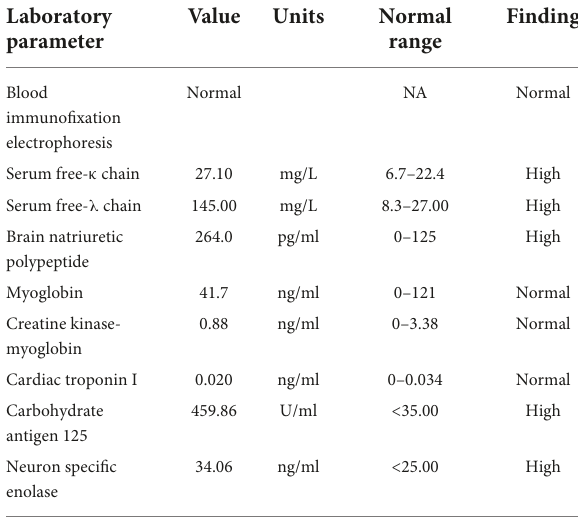
TABLE 1 Laboratory parameters at the time of kidney